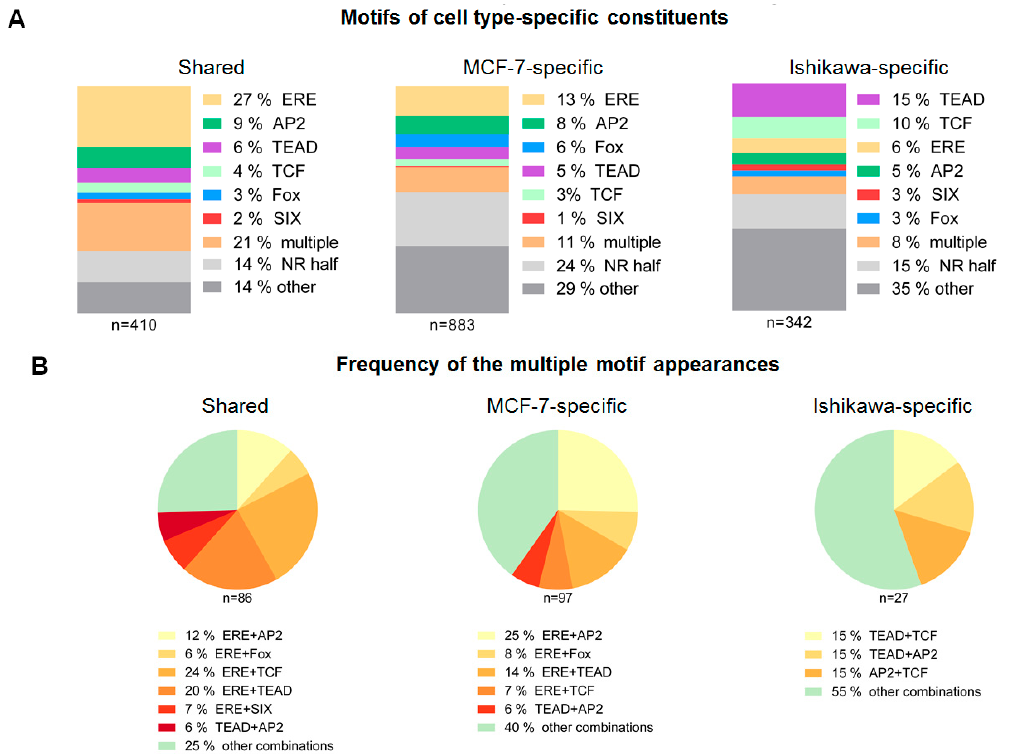
Figure 5. Motif composition within the cell line-specific constituents of the 99 shared SE regions. ( A ) The proportion of investigated DNA motifs within the 99 shared ER α -driven SEs visualized on three bar charts (stacked up to 100%) and classified according to Figure 4B. ( B ) Pie charts represent the frequency of the top multiple motif appearances defined on panel A.